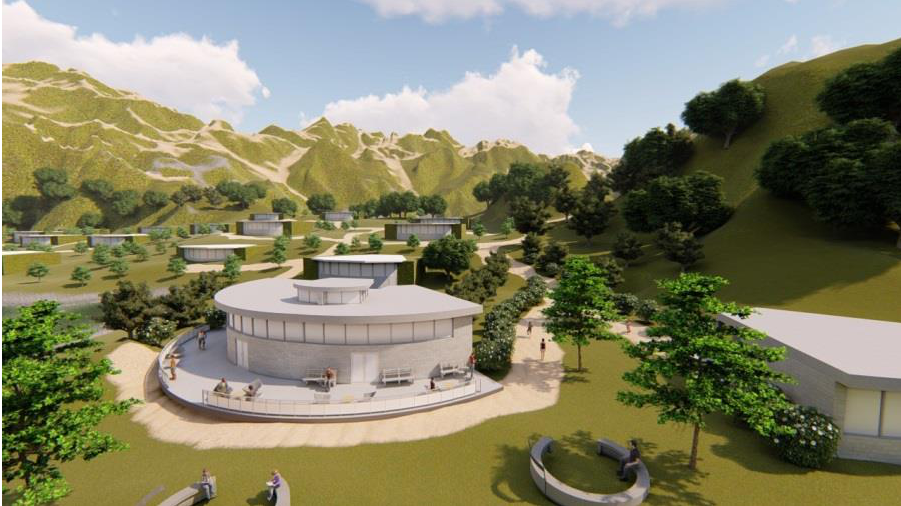
Figure 41. Visitor Centre and Tourist Settlement Lepenski Vir beneath Koršo Mountain. Centre of the community living in the houses. Lepenski Vir, Serbia (2019) by ArhiArhi (Predrag, Vladimir and Grigor Milošević)